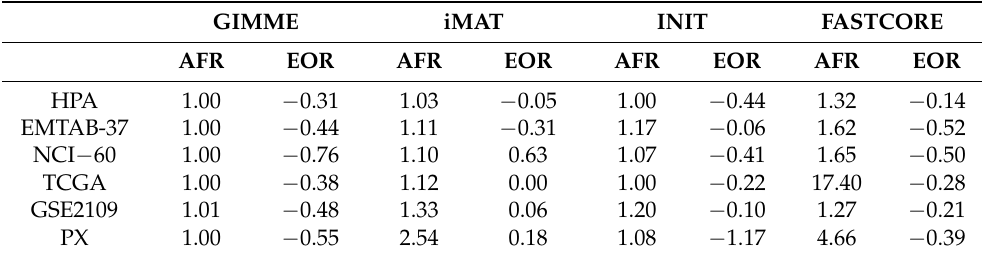
Table 3. The mean of AFR and EOR scores in all CGEMs. AFR and EOR are two indices to quantify Warburg effect in